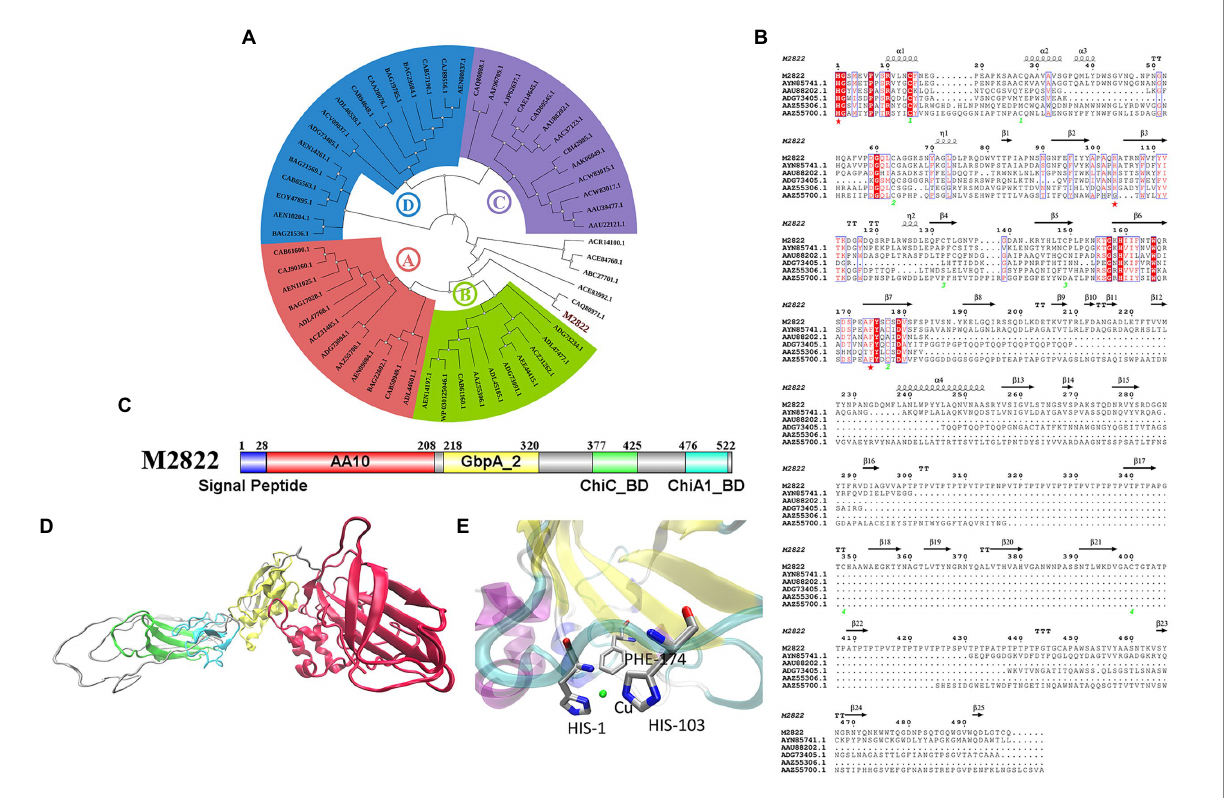
FIGURE 3 Bioinformatics analysis of M2822. (A) Phylogenetic tree analysis of M2822; (B) Multiple alignments of amino acid sequences of AYN85741.1, AAU88202.1, ADG73405.1, AAZ55306.1, AAZ55700.1 and M2822; (C) M2822 conserved domain analysis; (D) Cartoon representation of three- dimensional homology models of M2822. (E) Predicted 3-D model structures of M2822 active